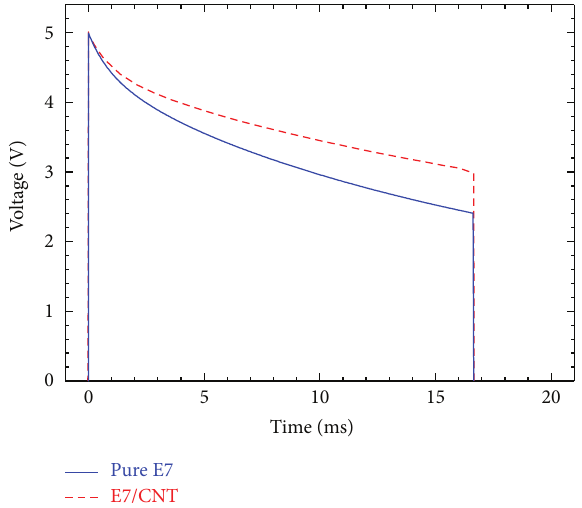
Figure 4: Voltage responses of doped and undoped E7 cells to a 5-V square-wave pulse of 15.6 𝜇